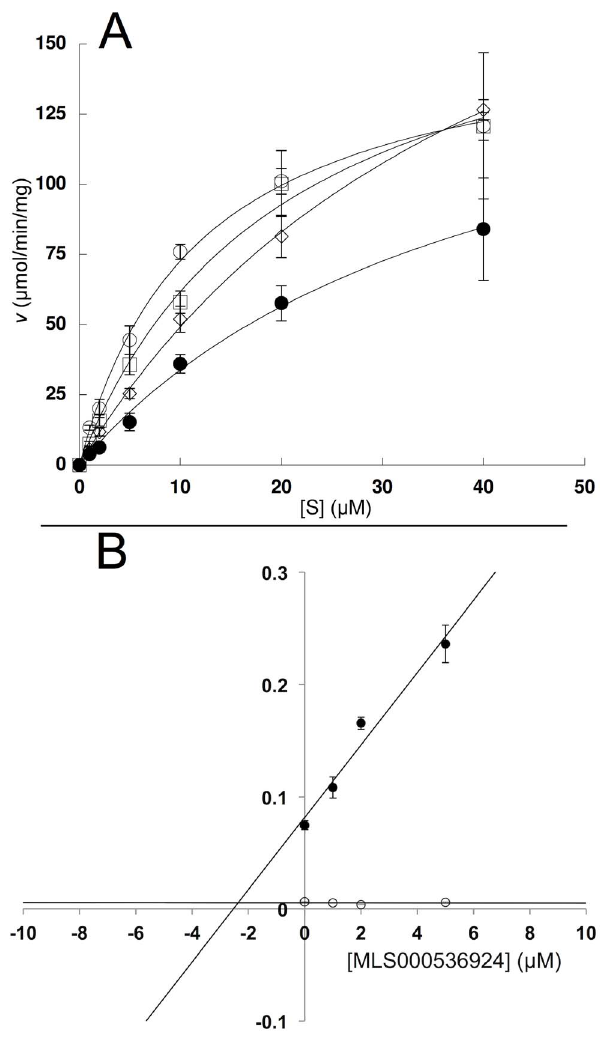
Figure 5. Steady-state kinetics data for the determination of K i for 15-LOX-2 with MLS000536924. (A) Initial enzymatic rate ( m mol/ min/mg) versus substrate concentration ( m M) at inhibitor concentra- tions of 0 m M (open circles) 1 m M (open squares) 2 m M (open diamonds) and 5 m M (closed circles) fitted to the Henri–Michaelis– Menten equation to yield V max ( m mol/min/mg) and V max /K M ( m mol/min/mg/ m M). All measurements were done in triplicate. (B) K M /V max replot (closed circles) (units are m M/ m mol/min/mg) versus [Inhibitor] ( m M), which yielded a K i of 2.5 + / 2 0.5 m M. 1/V max replot (open circles) (units are 1/ m mol/min/mg) versus [Inhibitor] ( m M), value did not change with